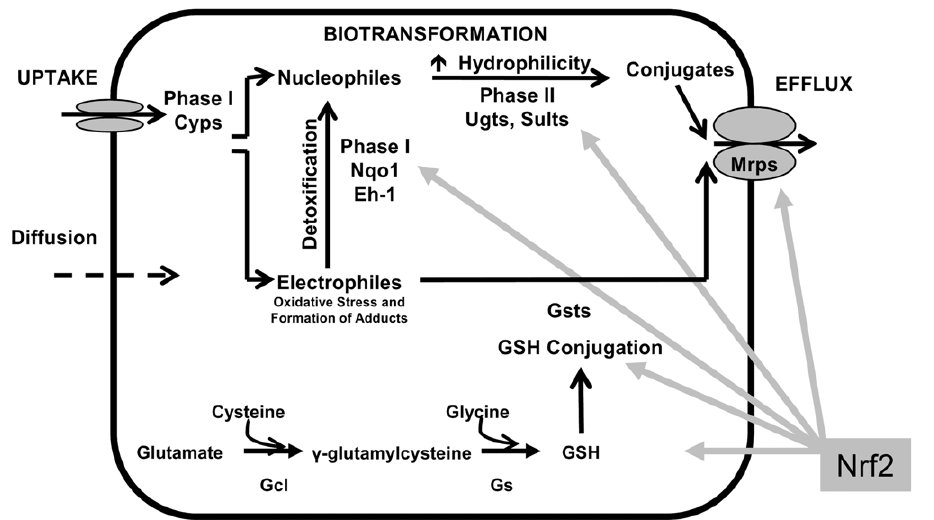
Figure 8. Proposed regulatory model for the role of Nrf2 on drug metabolizing genes in liver. Activation of Nrf2 had a minor effect on uptake transporters and P450 phase-I enzymes that activate xenobiotics into toxicants, markedly induces genes encoding other phase-I enzymes and phase-II enzymes that detoxify toxicants, and also induces efflux transporters that facilitate the elimination of toxicants.